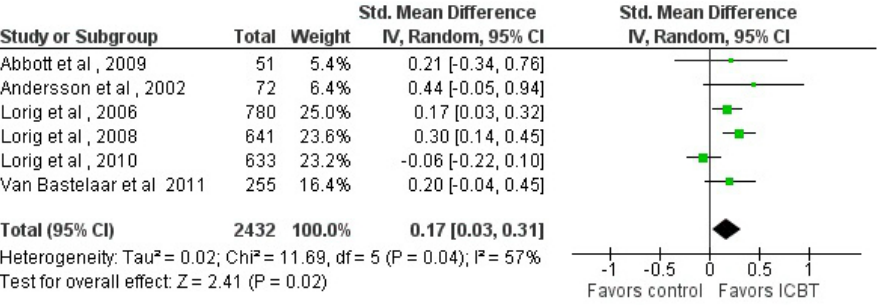
Figure 8. Forest plot of standardized mean differences of the effect on disease-specific distress of Internet-based cognitive behavioral therapy compared with a passive control